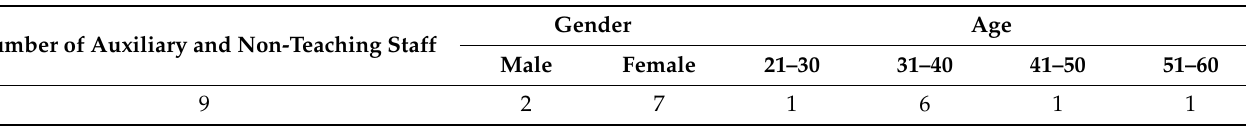
Table 3. Gender, age, and number of auxiliary and non-teaching staff within the Marketing specialization, undergradu- ate